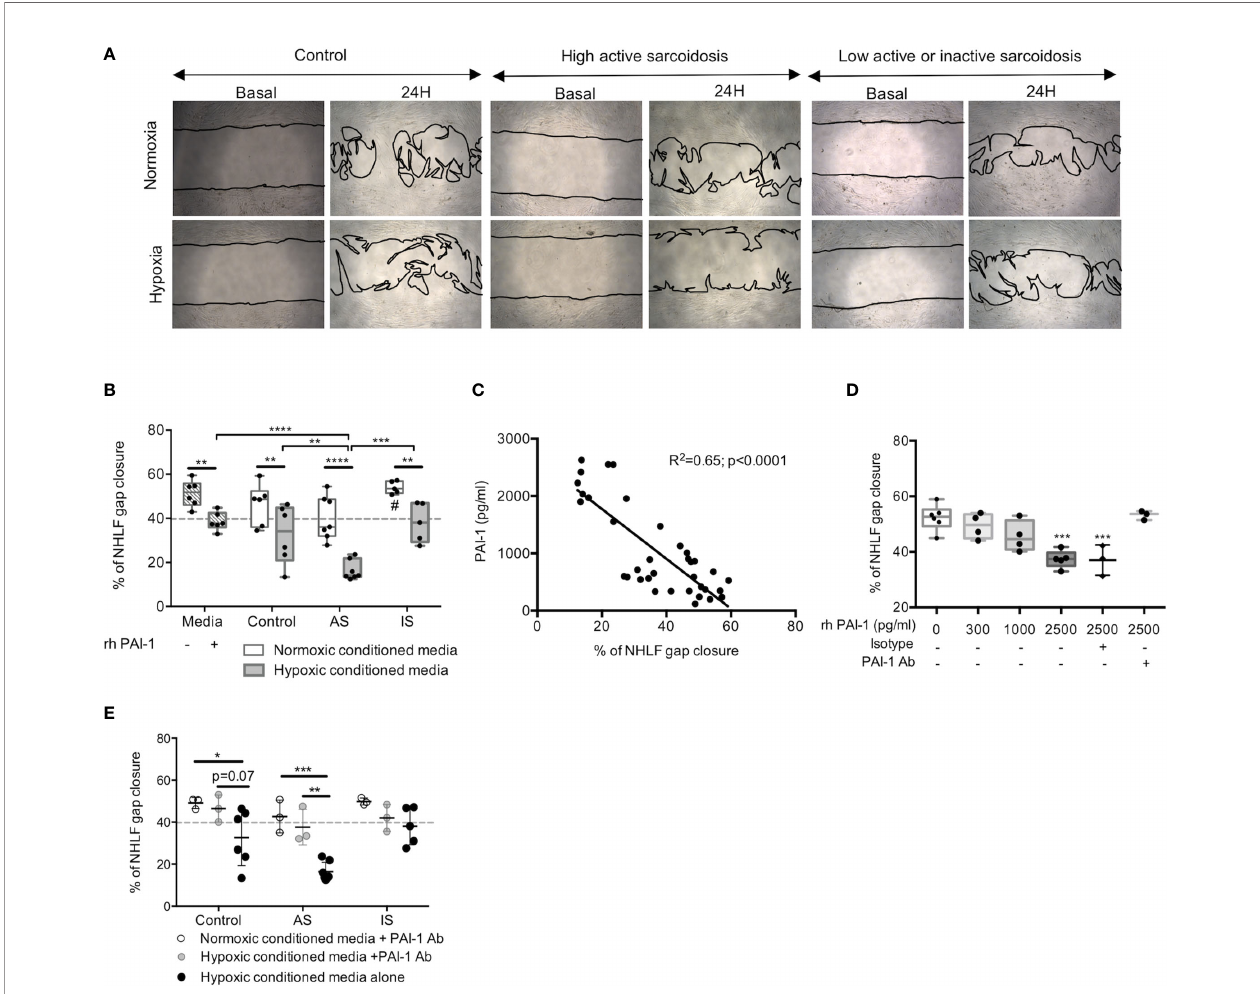
FIGURE 6 | Secretion of PAI-1 by hypoxic MD-macrophages from high active sarcoidosis inhibited lung fi broblast migration. (A) Representative contrast-phase microscopy images of NHLF during gap closure assays at basal time and after 24hrs of incubation with conditioned media from controls or high active sarcoidosis (AS) or low active or inactive sarcoidosis (IS) patients MD-macrophages exposed to normoxia or hypoxia. (B) Quantitative analysis of NHLF gap closure assay comparing media alone or with 2500pg/ml recombinant human PAI-1 (rh-PAI-1) or normoxic or hypoxic conditioned media from MD-macrophages in controls, AS, and IS. Each point indicates a patient and/or control (n=5-7/group) (C) Correlation (Pearson Test) between PAI-1 level (pg/ml) in normoxic or hypoxic MD- macrophages conditioned media from sarcoidosis and controls and percentage of NHLF gap closure. Each point indicates a patient and/or control (n=3-6/group). (D) Dose effect of rh-PAI-1 on NHLF gap closure reversed by PAI-1 Ab (n=3 independent experiments); (E) Effect of PAI-1 antibody (PAI-1 Ab) added to the conditioned media on NHLF gap closure assay. Each point indicates a patient and/or control (n=3/group). Results are expressed as box plot showing 25 th and 75 th percentile and median (B, D) or mean with SD (E) . *p < 0.05; **p < 0.01; ***p < 0.001; ****p < 0.0001 in Anova two-way (D, E) and Anova two-way with repeated measures (B) with Sidak post-hoc test. # p < 0.05 between normoxic conditioned media from AS and